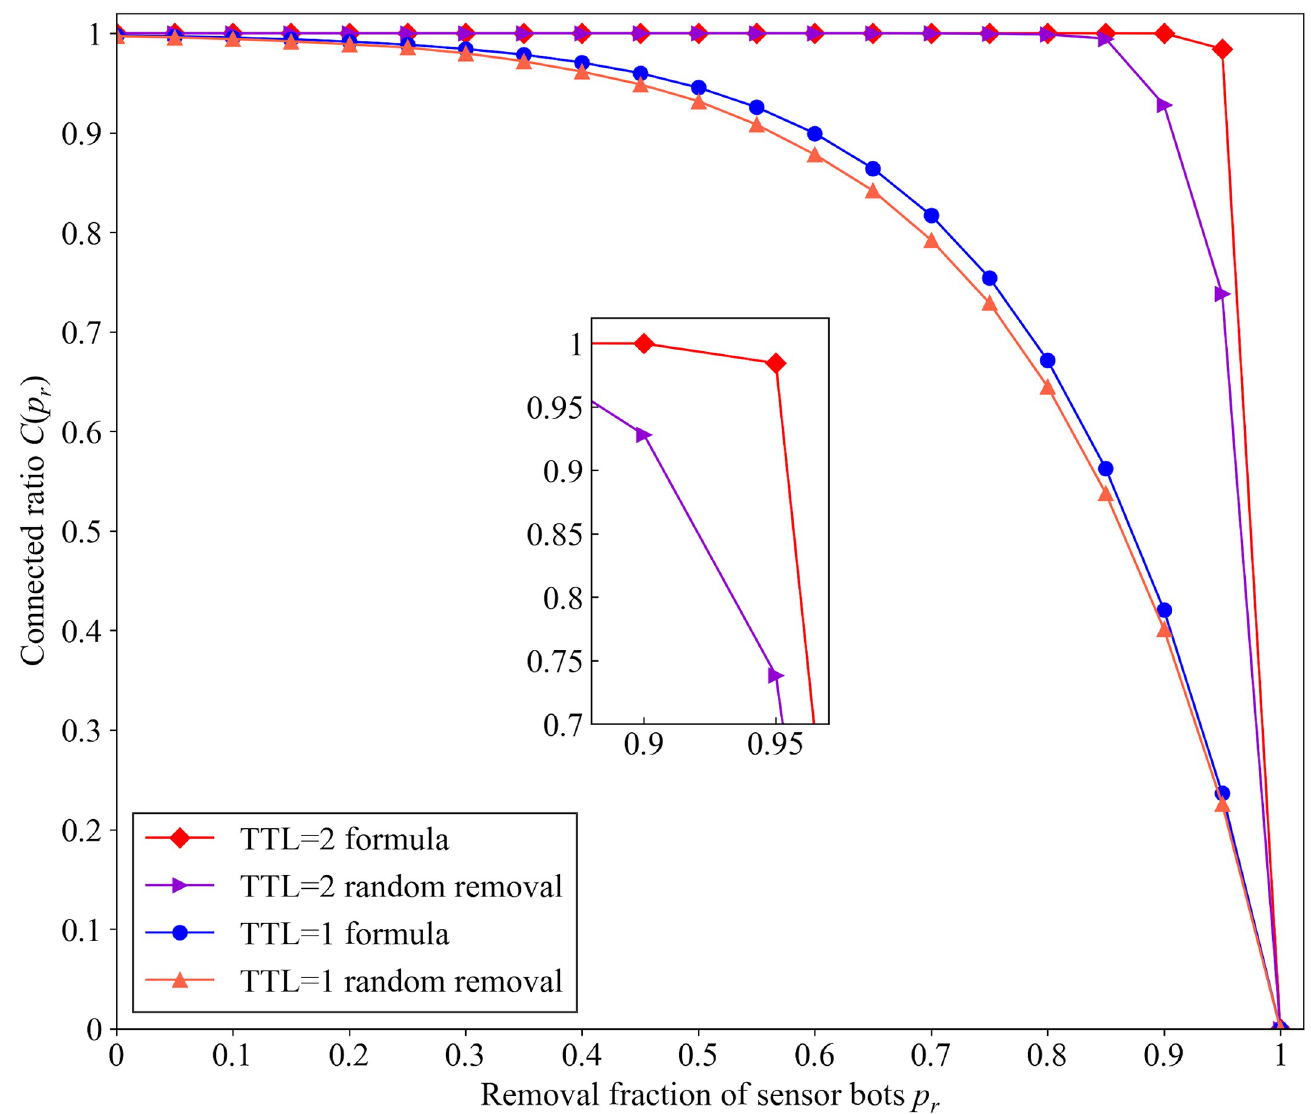
Fig 9. Comparison of the Eq (7) and simulation results with different TTL